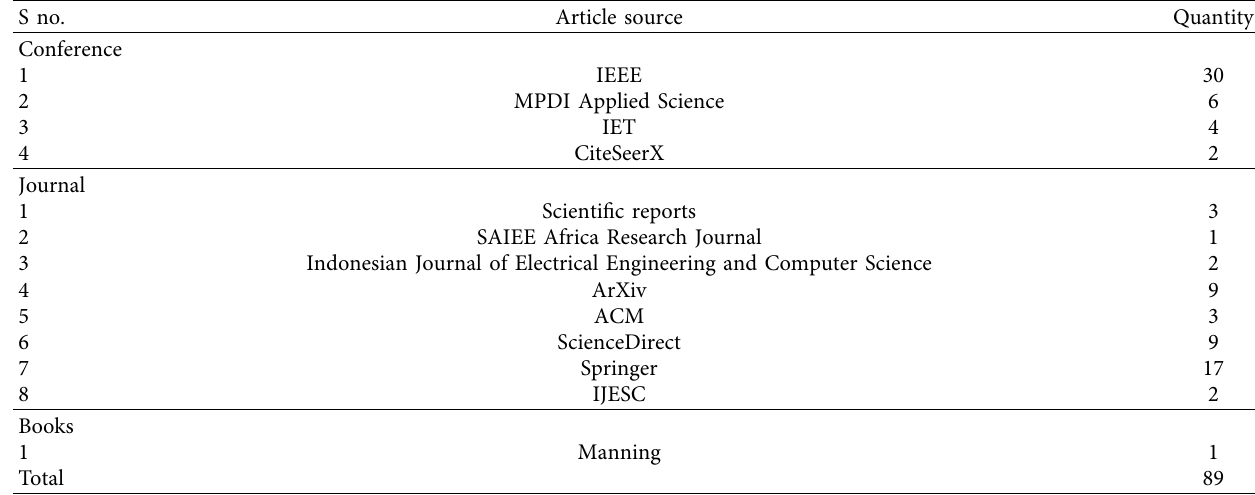
Table 6: Sources of the articles reviewed.